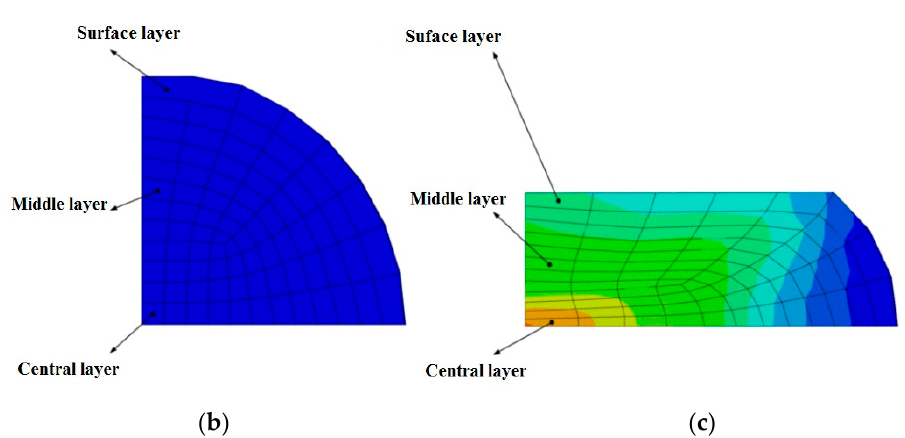
Figure 3. Simulation of wire flat rolling process. ( a ) Roll meshing in micro-flat-rolling of wire; ( b ) cross-section before rolling; ( c ) cross-section after rolling.